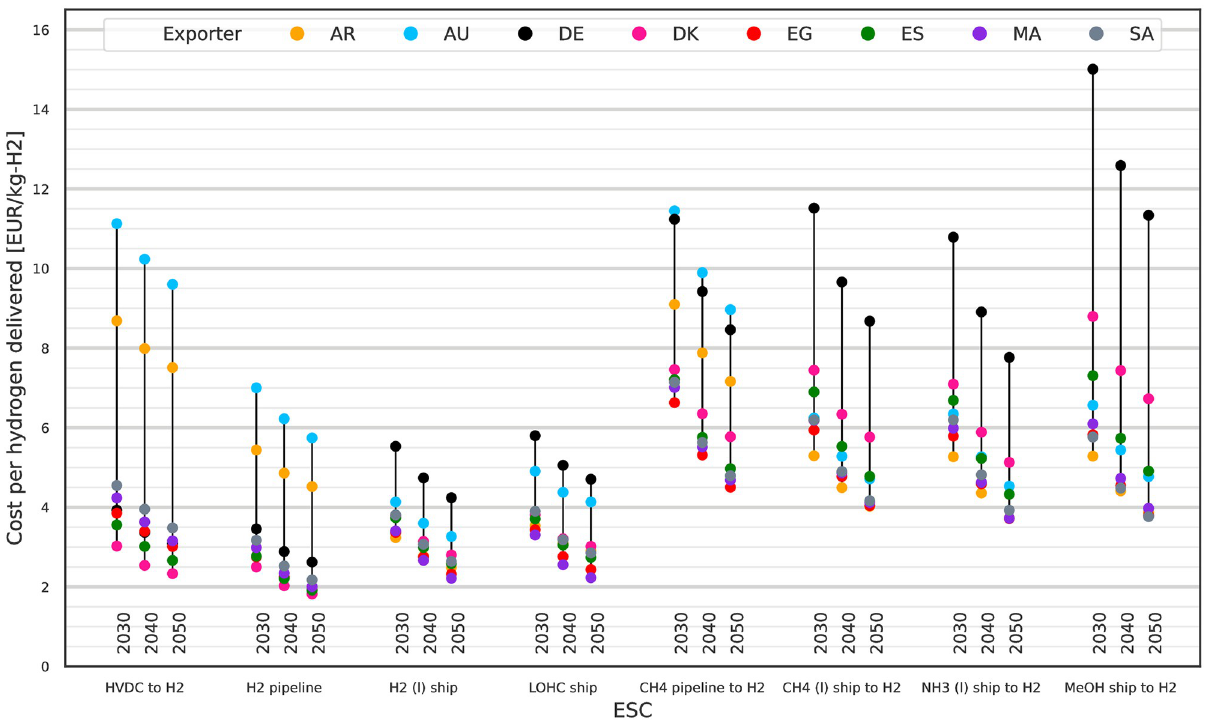
Fig 7. Levelised Cost of Hydrogen (LCoH) for 2030 to 2050 using extended ESCs. Direct hydrogen imports have lower LCoH than the alternative ESCs using methane, methanol or ammonia as energy carrier. The extended ESCs include extra process steps for cracking of the energy carrier to deliver hydrogen. All costs assuming 10% p.a.